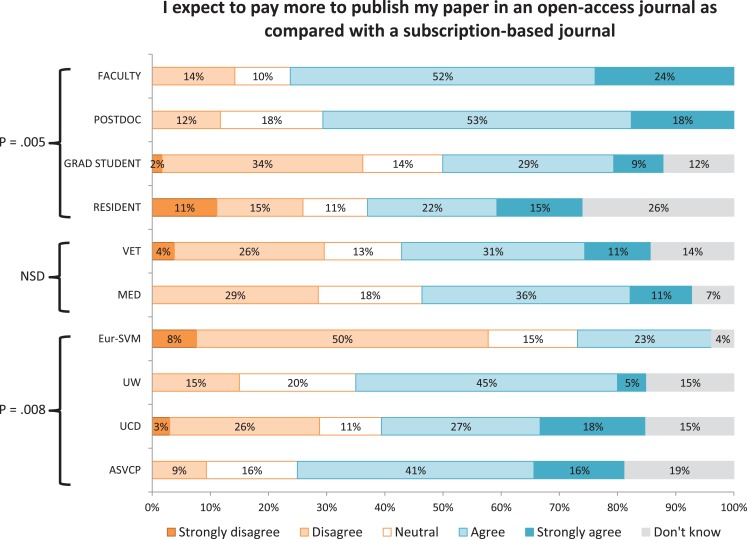
Differences in levels of agreement based on role, veterinary vs medical audience, and site for survey statement #2.